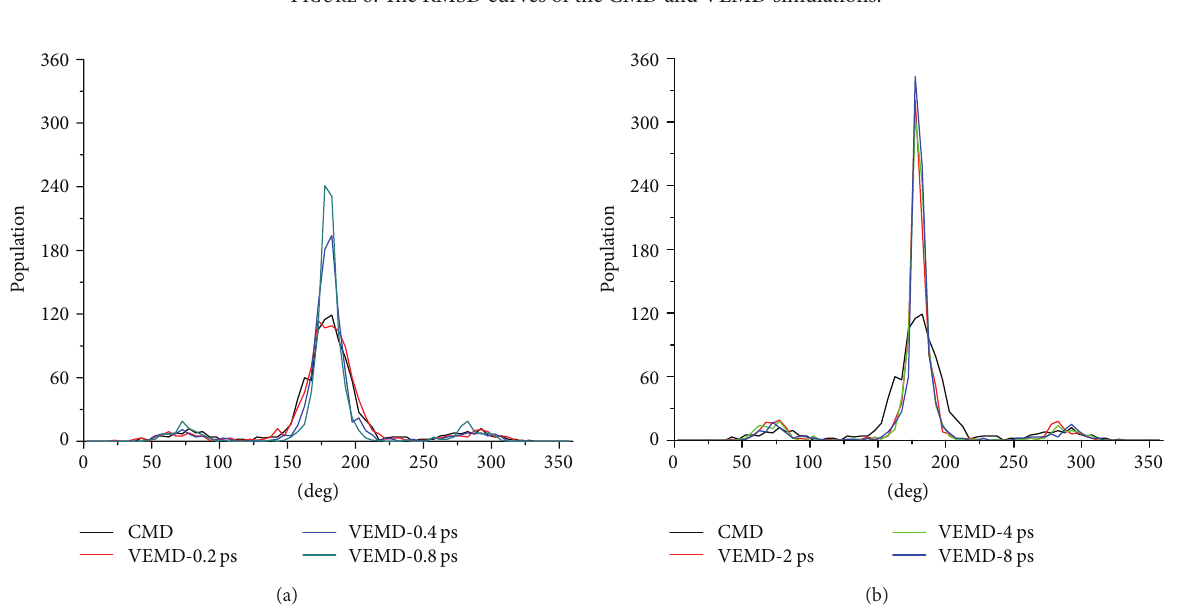
Figure 7: The torsion distributions of the final structures derived from the CMD and VEMD